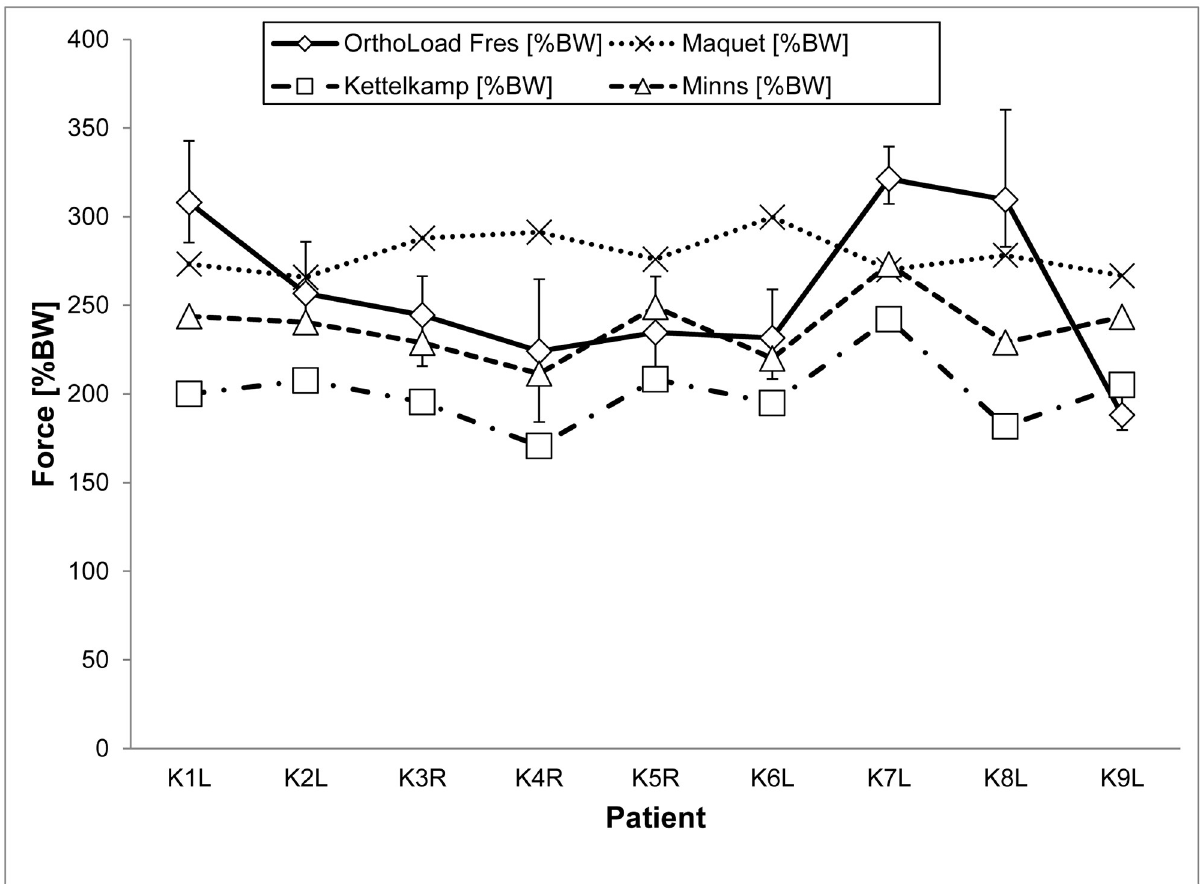
Fig 7. Calculated resultant knee joint forces based on the models of Maquet, Kettelkamp and Minns with corresponding in vivo forces for a one- leg stance. The error indicators demonstrate the minimum/maximum values. Forces in %BW.